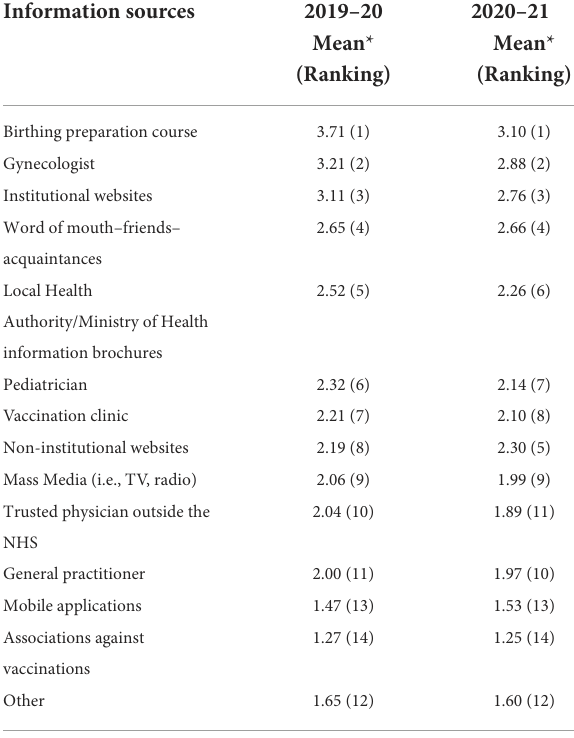
TABLE 4 Perception of the usefulness of different information sources, before and during the COVID-19 pandemic in the flu